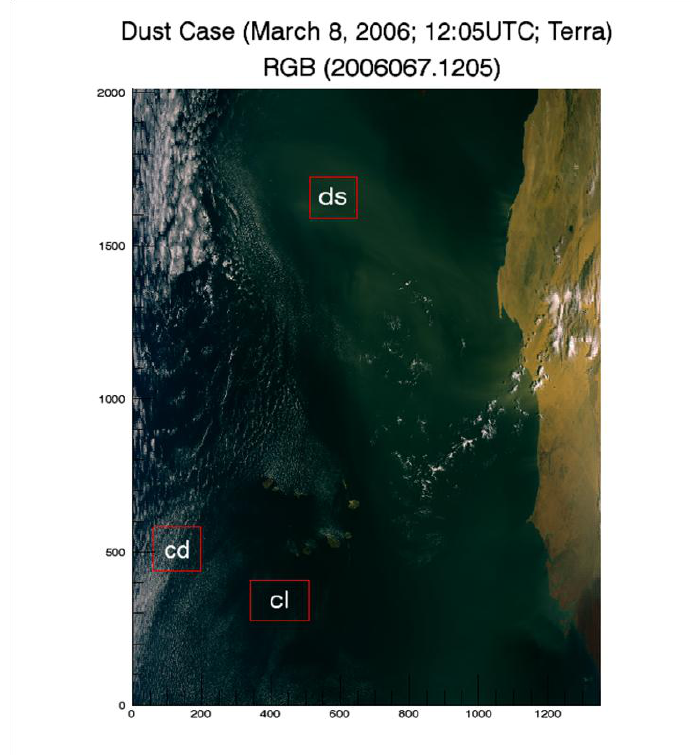
Figure 6. Terra MODIS RGB image for a granule with dust plume over coastal ocean of Africa. cl, ds, cd symbols represent clear-sky, dust, and cloud,